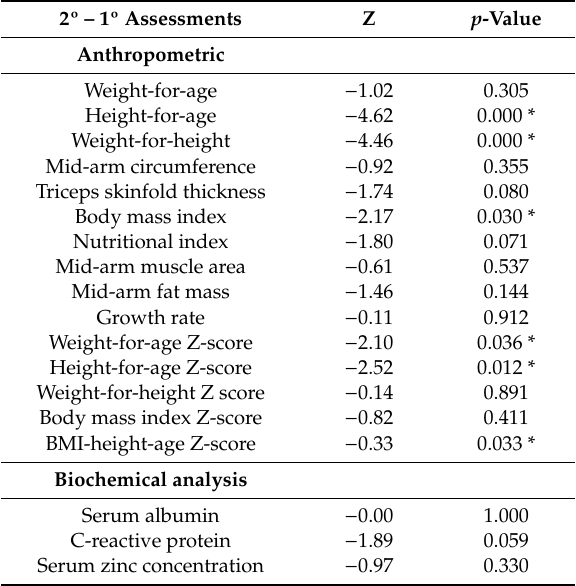
Table 4. Statistical changes after zinc supplementation in the whole series ( n = 35).